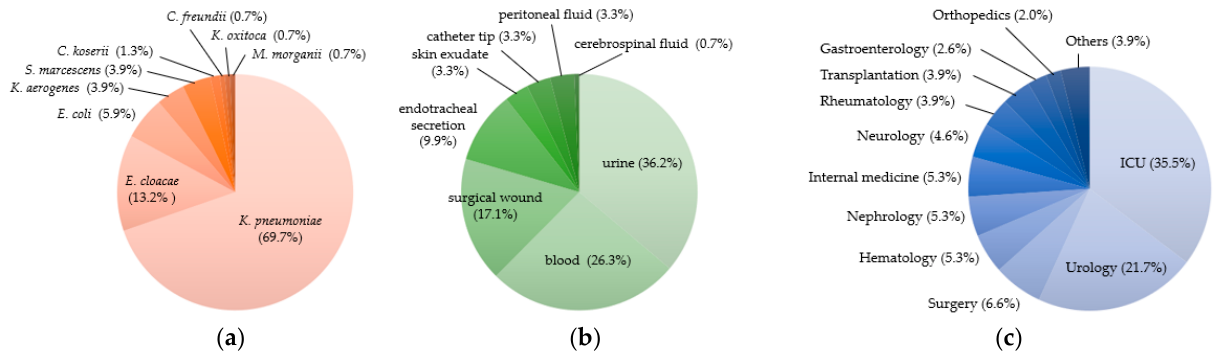
Figure 1. Bacterial species of the 152 CPE isolates ( a ), clinical specimens ( b ) and clinical departments ( c ) from which the CRE isolates were derived (Pedro Kour í Institute, from 2016 to